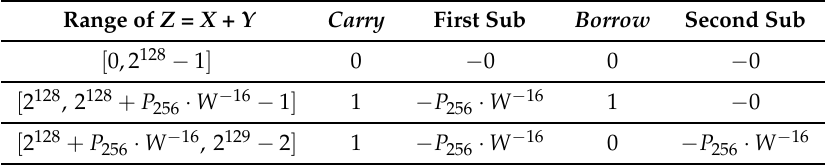
Table 1. Number of cases of carry and borrow in modular addition. Range of Z = X + Y Carry First Sub Borrow